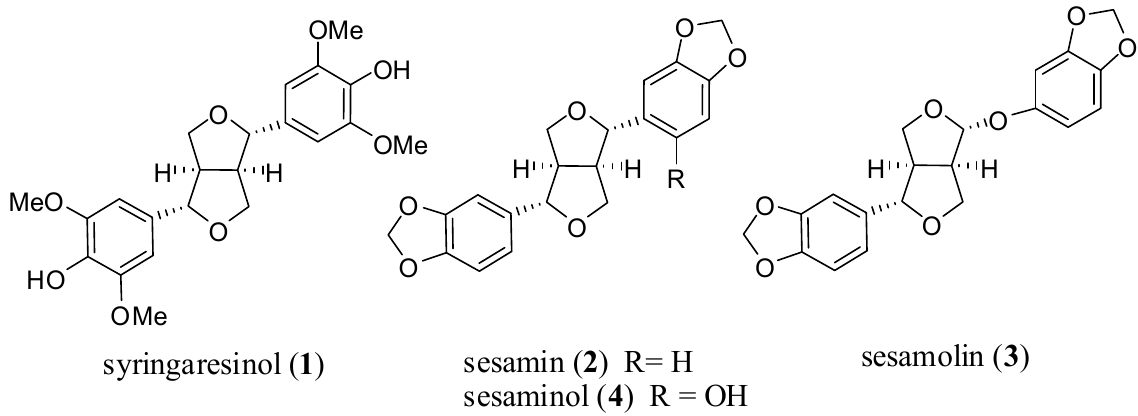
Figure 1. Structures of bioactive furofuran